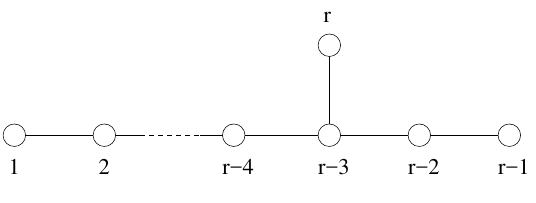
Figure 2 . The Dynkin diagram for E r